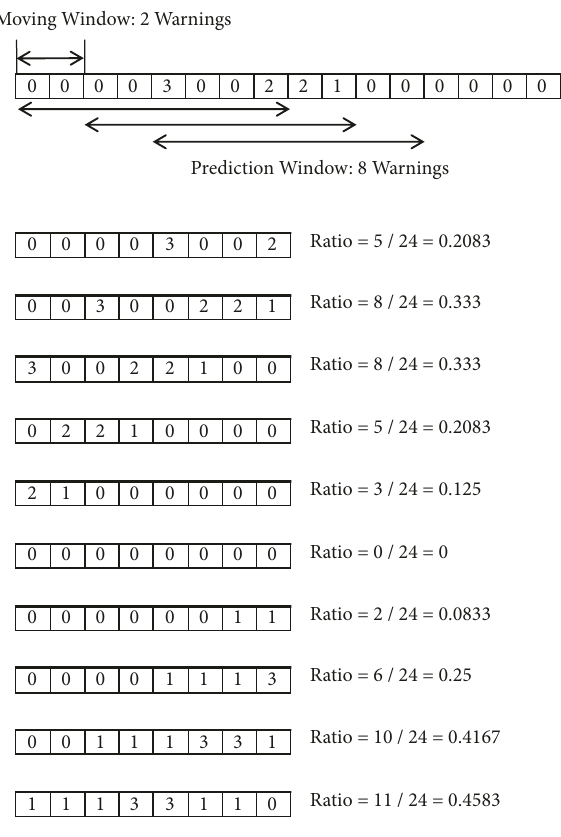
Figure 18: Prediction algorithm results for subject 1 while climbing upstairs. Table 6: Information for test subject